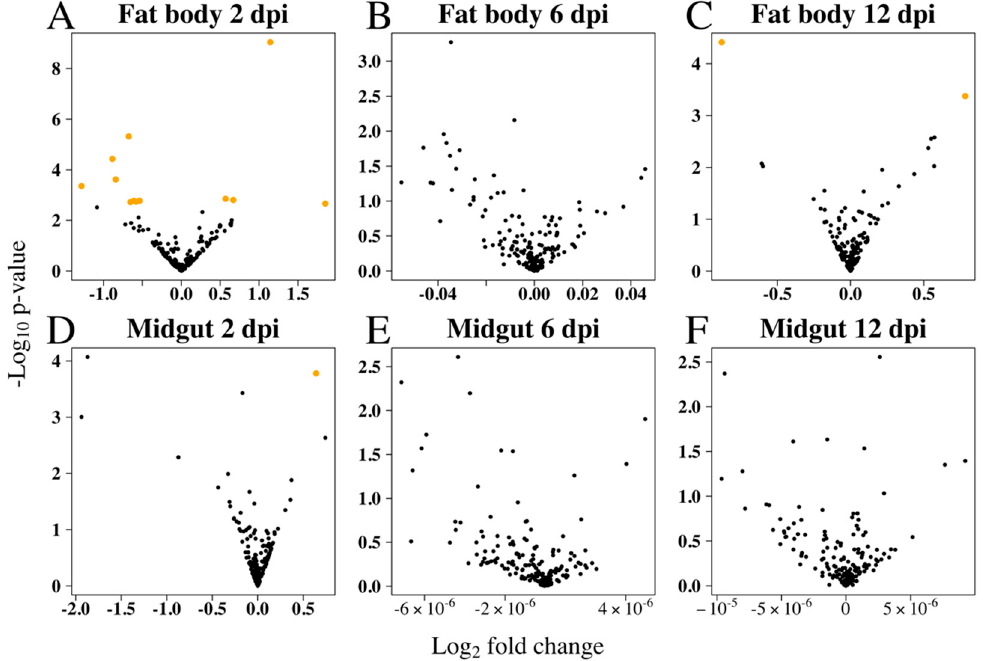
Figure 4. RRV caused di ff erential expression of Ae. aegypti miRNAs mostly early in infection. Volcano plots show miRNA log 2 fold changes due to RRV infection in fat body at ( A ) 2 dpi, ( B ) 6 dpi, and ( C ) 12 dpi, and in midgut at ( D ) 2 dpi, ( E ) 6 dpi, and ( F ) 12 dpi. Significantly di ff erentially expressed miRNAs (orange) were found in fat body samples at 2 dpi and 12 dpi and in midgut samples at 2 dpi.